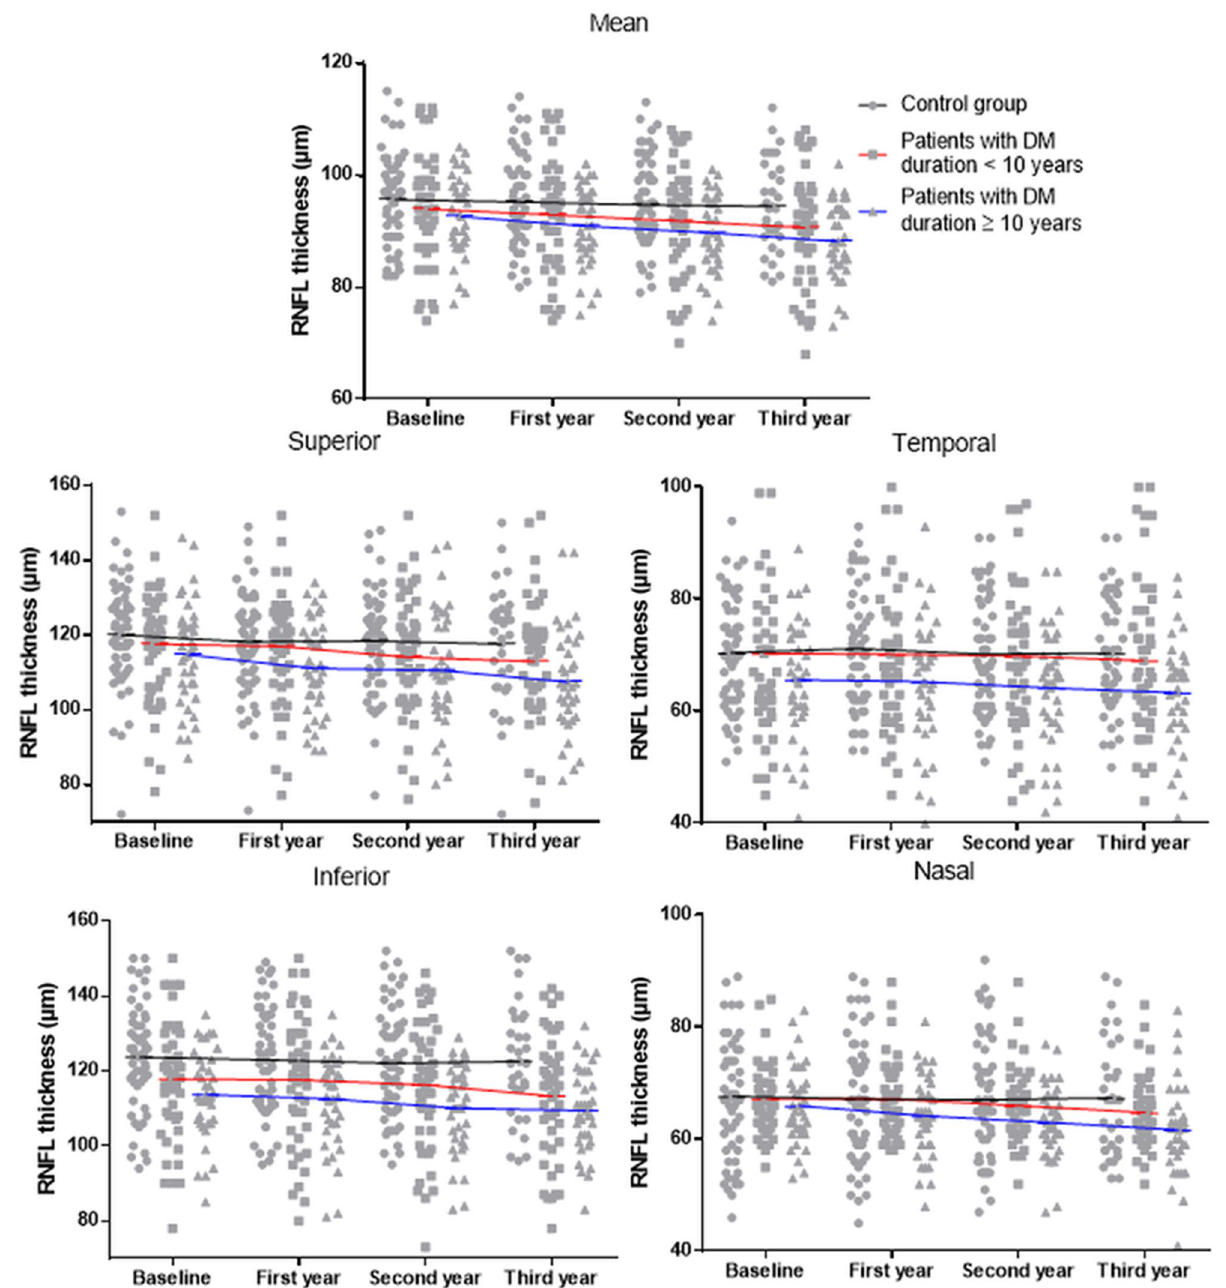
Figure 2. Scatterplots and line graphs of the mean and sectoral peripapillary retinal nerve fiber layer (RNFL) thicknesses at each visit in normal controls, patients with DM duration < 10 years, and patients with DM duration ≥ 10